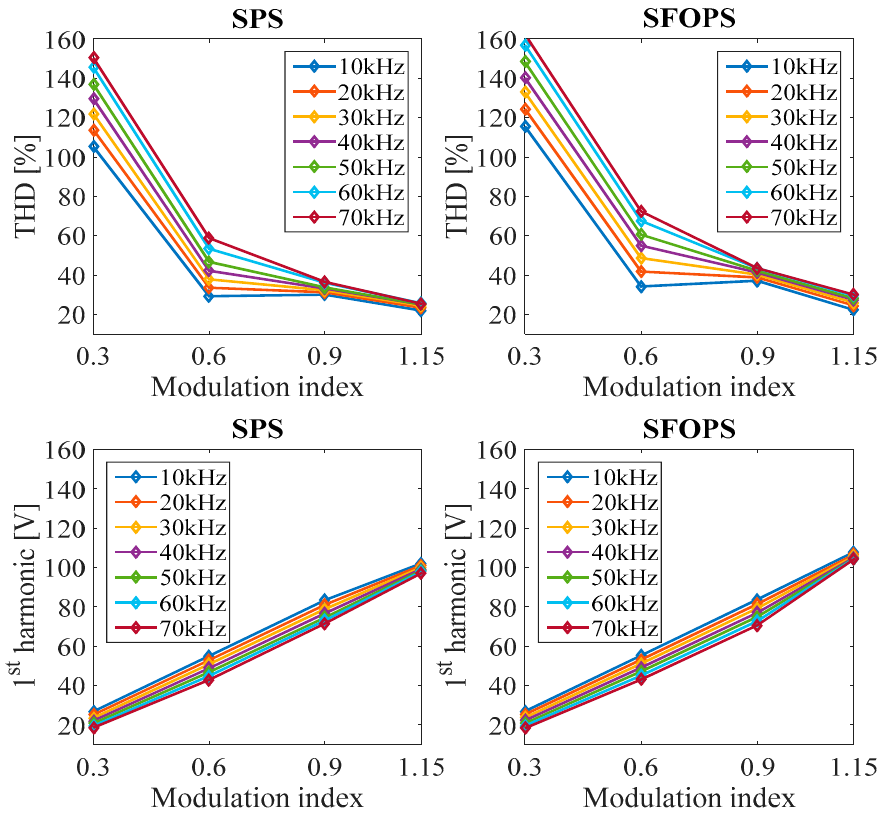
Figure 17. Experimental THD% and fundamental amplitude trends of SPS and SFOPS schemes.